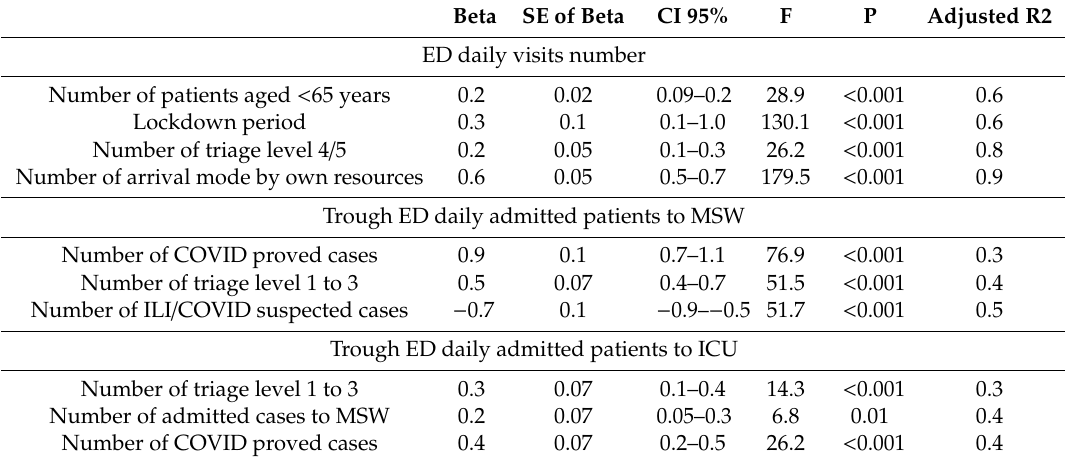
Table 2. Multifaceted regression model: predictors of emergency department and hospital